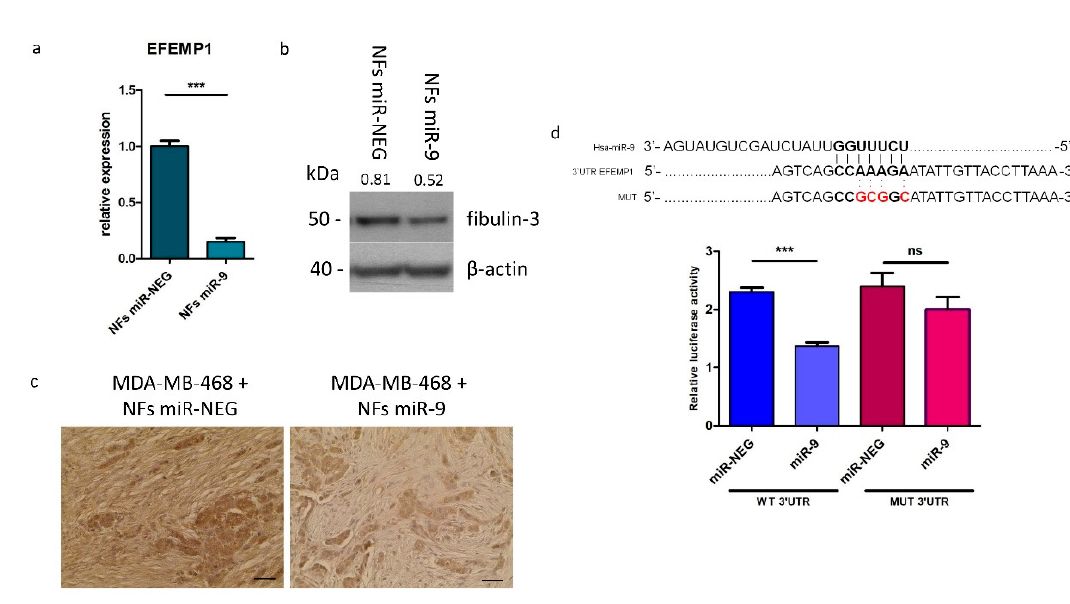
Figure 2. EFEMP1 is a direct target of miR-9. Evaluation of EFEMP1 gene and protein levels by qRT-PCR ( a ), western blot ( b ) and IHC ( c ). qRT-PCR and western blot analysis were performed on NFs miR-9 vs control. Protein expression levels are indicated above western blot bands. IHC images show fibulin-3 expression in ex vivo samples of tumors grown from the co-injection of MDA-MB-468 cells and NFs miR-NEG/9. Images are representative; the experiment was performed on 6 tumors per group. Scale bars 2.5 μ m ( d ). Luciferase assay performed on HEK293 cell line transfected with miR-9 or control and with wild-type or mutated EFEMP1 3 ′ UTR (mutated sequence shown above). Data are presented as the mean of three biological replicates ±SEM (*** p < 0.001, ns = non-significant).